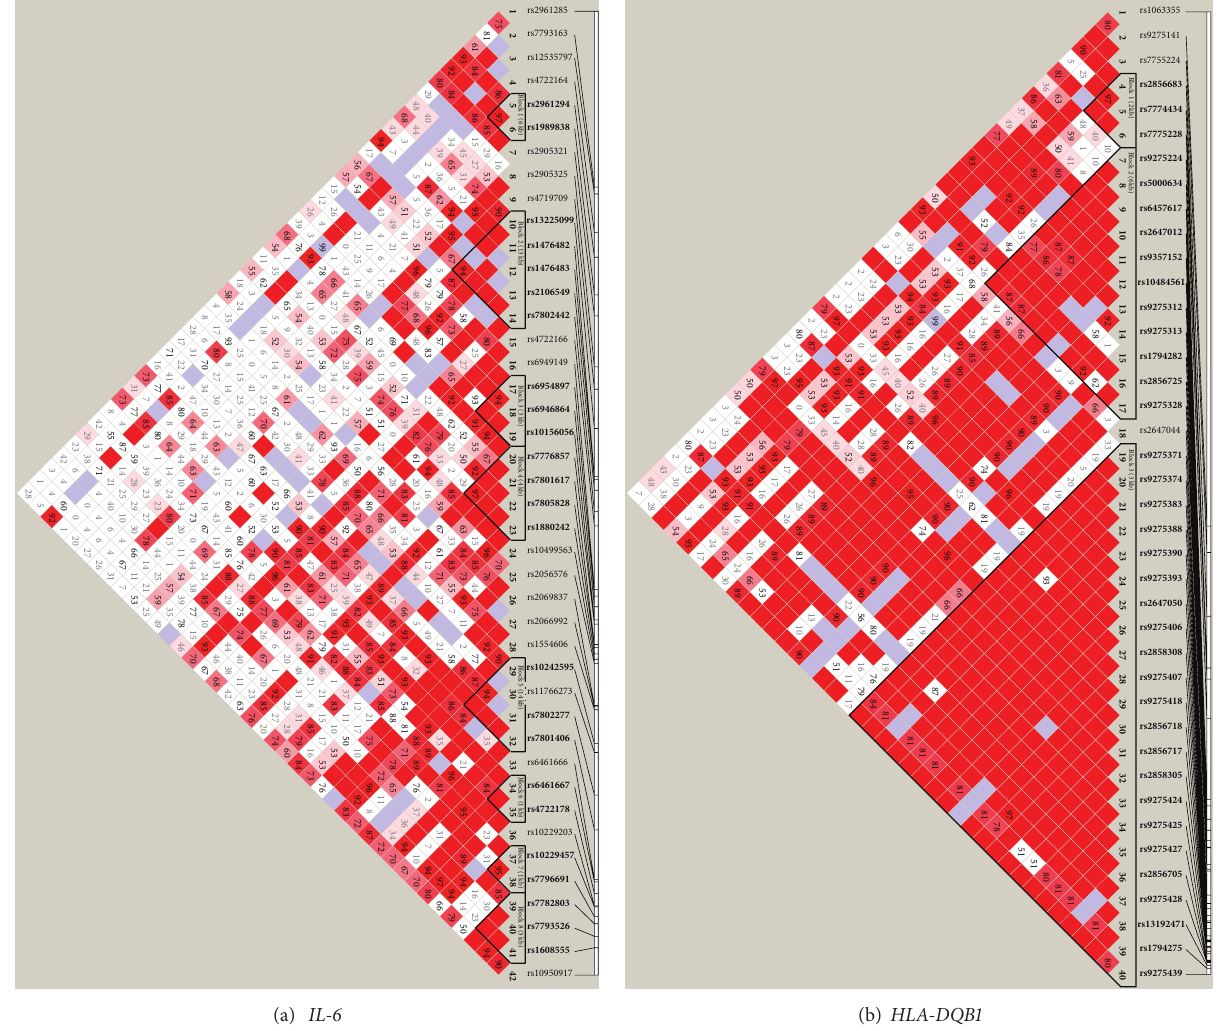
Figure 2: Linkage disequilibrium maps of the two significant genes, measured as D 󸀠